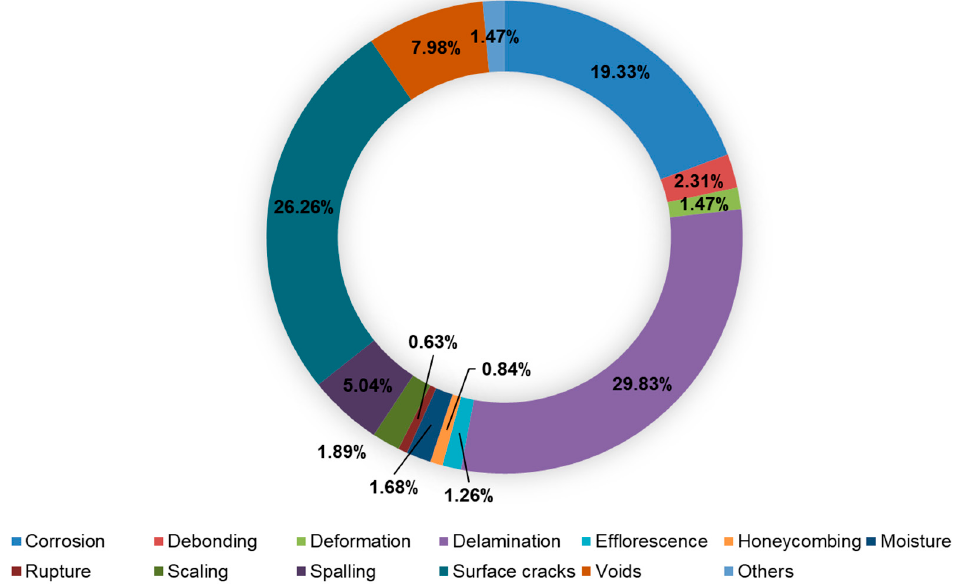
Figure 13. Distribution of the tackled defects in the CBD_NDT domain.